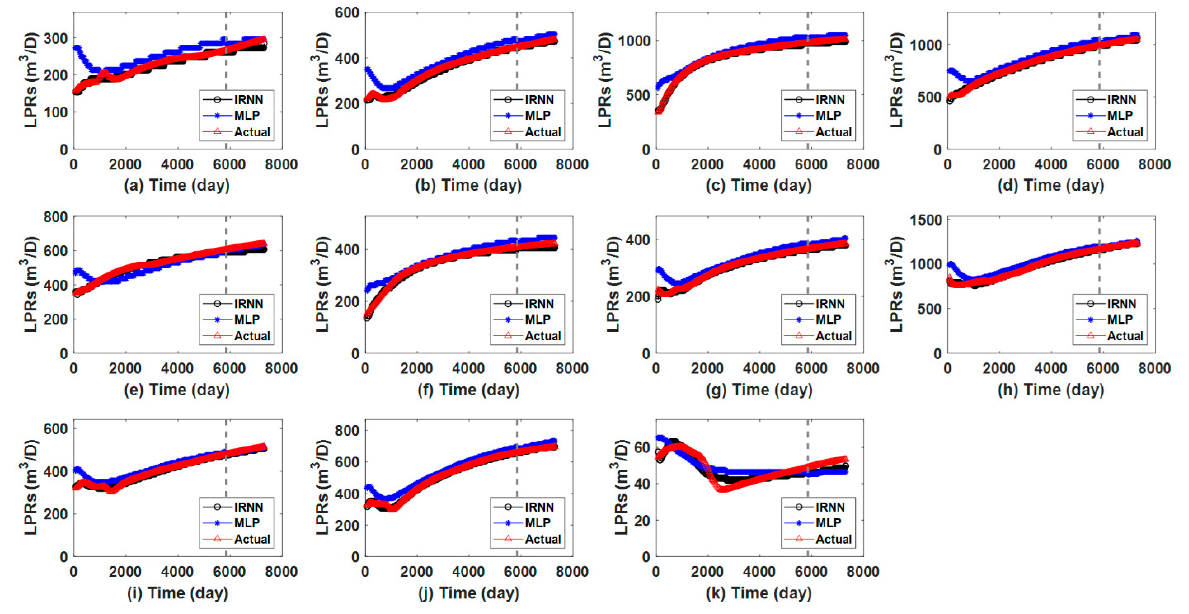
Figure 8. The liquid production rate curves of Olympus model. The red lines with triangles represent the actual results obtained by the simulator, the black lines with circles represent the results obtained via IRNN, and the blue lines with dots are the results obtained via MLP. The history matching and predicting periods are divided by the grey vertical dashed line. From PRO-1 to PRO-11, the liquid production rates of 11 producers are demonstrated in ( a – k ) successively.